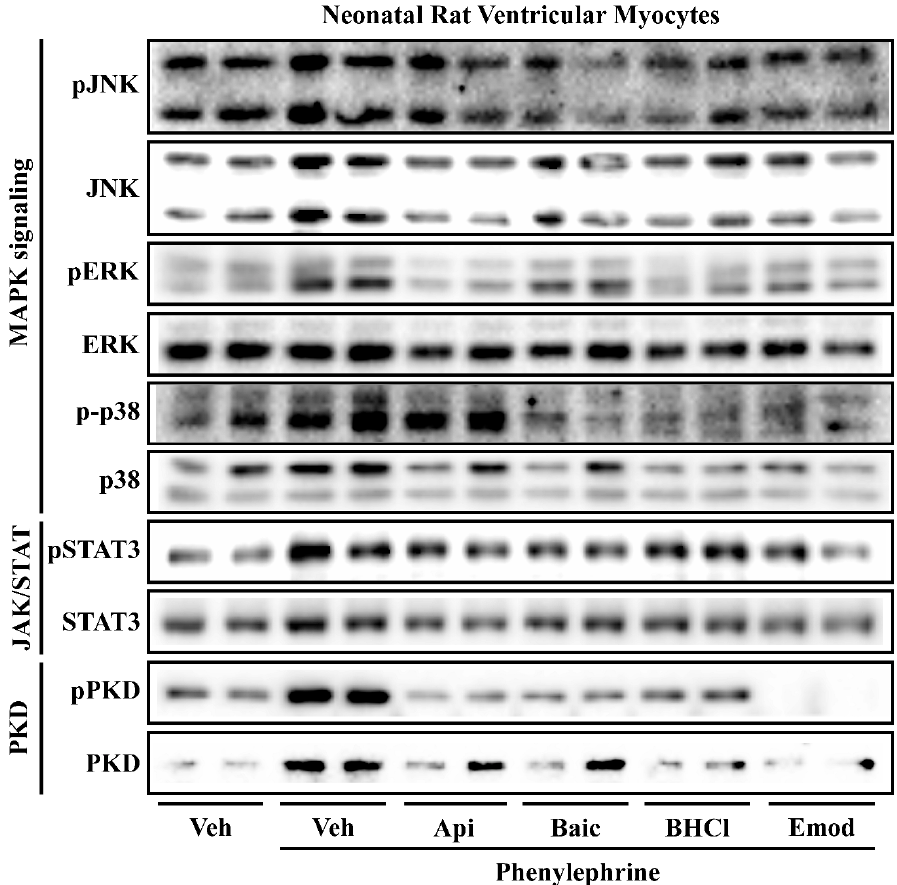
Figure 6. Phytochemicals regulate overlapping and divergent signaling pathways in NRVMs in response PE-induced hypertrophy. Neonatal rat ventricular myocytes (NRVMs) were treated with vehicle (Veh) or phenylephrine (PE; 10 µ M) in the absence or presence of phytochemicals (apigenin (Api); baicalein (Bac); berberine hydrochloride (BHCL), or emodin (Emod)). NRVMs were co-treated with PE or 10 µ M of specified phytochemicals for 48 h prior to cell lysis and immunoblot analysis for MAPK signaling (phospho-ERK, total ERK, phospho-JNK, total JNK, phospho-p38, total p38), JAK/STAT signaling (phospho-STAT3, total STAT3) and PKD signaling (phospho-PKD, and total PKD). Immunoblots were imaged with the BioRad Chemi-Doc XRS+.